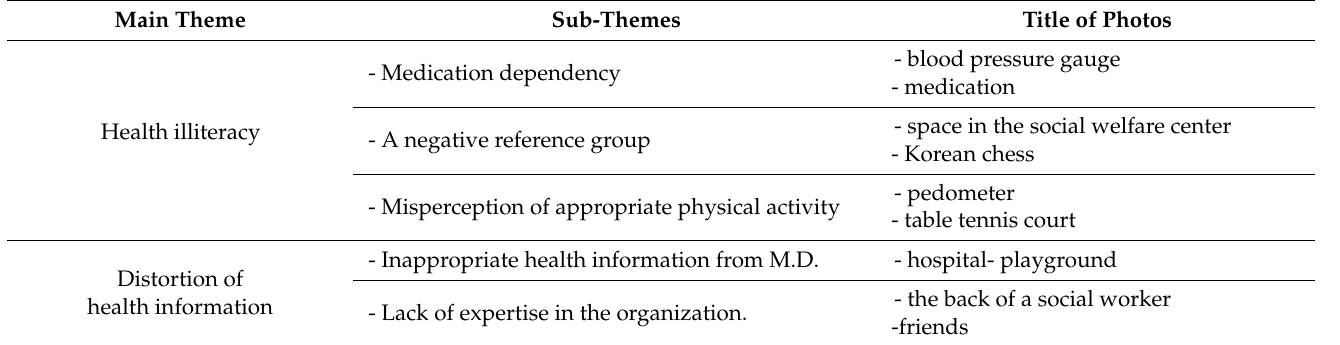
Table 5. Presentation of the obtained